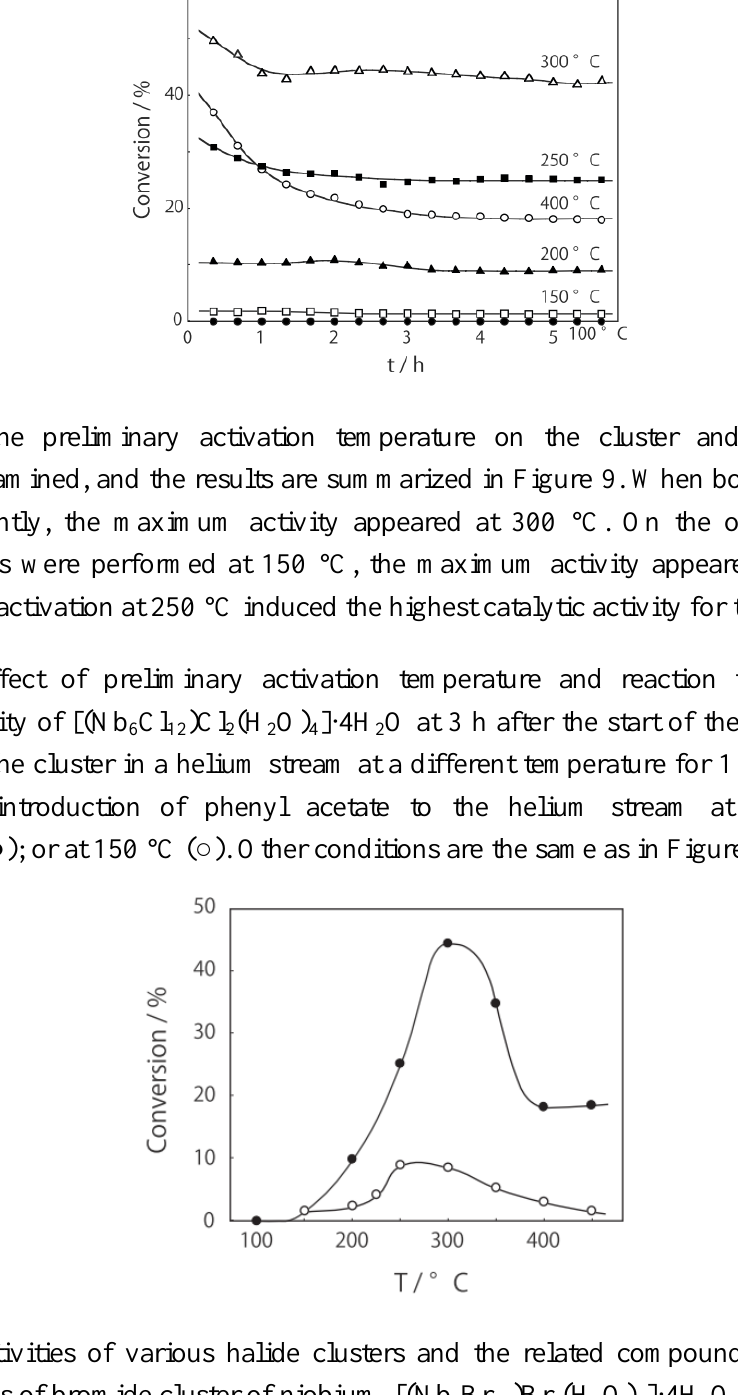
Cl )Cl (H O) ]·4H O at different temperatures. Following 6 12 2 2 4 2